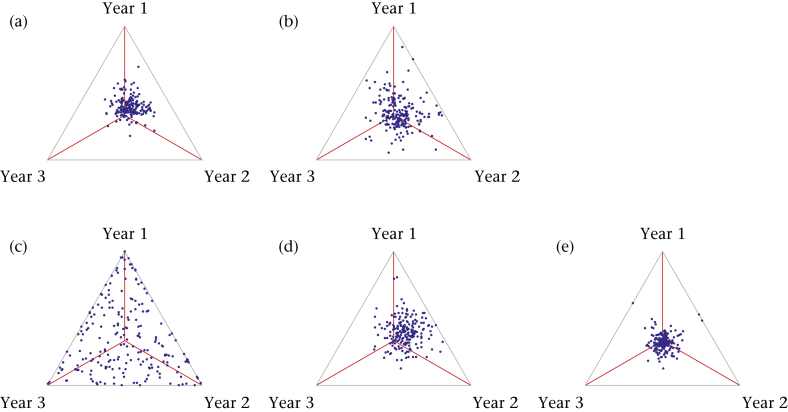
Simplex plots of repeatabilities for 210 individuals observed over three winter seasons of social network data collection. Each point represents one individual, and a perfect correlation between all three seasons is the central intercept of axes. Data are scaled between 0 and 1 within each season. Five winter-long measures of social behaviour are shown: (a) average group size, (b) unweighted degree, (c) betweenness centrality, (d) association strength and (e) clustering coefficient.